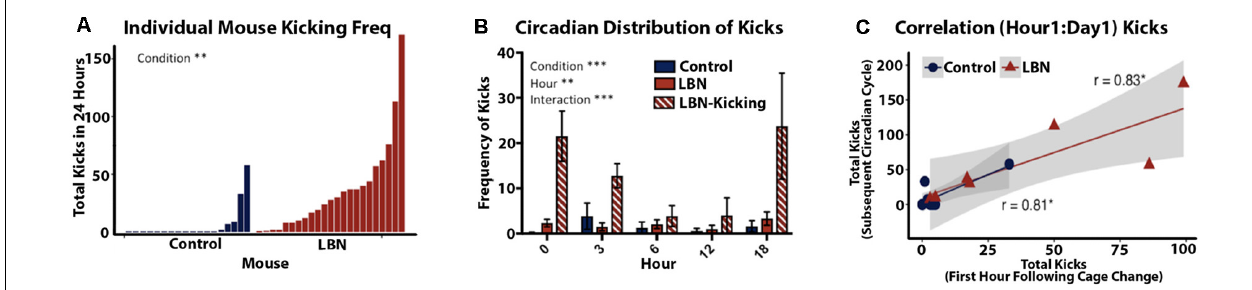
FIGURE 4 | Quantification of LBN effects on frequency and predictability of abusive-like kicking behavior. (A) Quantification of kicking behavior for individual dams sampled from five selected time points over a 24 h period (P4–P5). Frequency of maternal kicking significantly differs by condition ( t ( 30.5 ) = 3.28, p = 0.0026). (B) Circadian distribution of kicking show a significant effect of condition ( F ( 2,159 ) = 22.94, p < 0.0001), hour ( F ( 4,159 ) = 3.624, p = 0.0074) and an hour × condition interaction ( F ( 2,159 ) = 22.94, p < 0.0001) with LBN dams engaging in higher kicking across the day. (C) A positive correlation was found between the first hour of kicking and frequency of kicking across the following day ( r = 0.87, p = 2.1 × 10 − 5 , n = 15). The first hour following cage change was highly predictive dam’s kicking phenotype for control ( r = 0.81, p = 0.013, n = 8) and LBN dams ( r = 0.83, p = 0.021, n = 7).